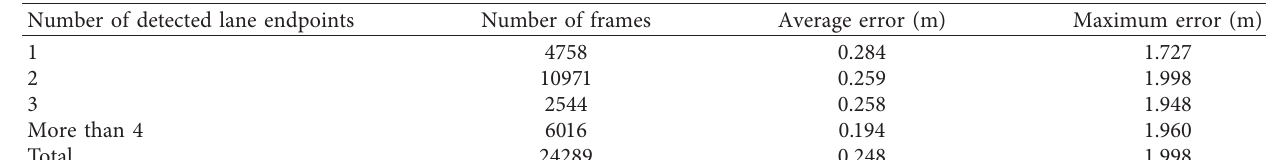
Figure 12: Example of estimated camera position error caused by a falsely detected lane endpoint: (a) a falsely detected lane endpoint; (b) estimated camera positions. Table 4: Localization error of the PT-based method.